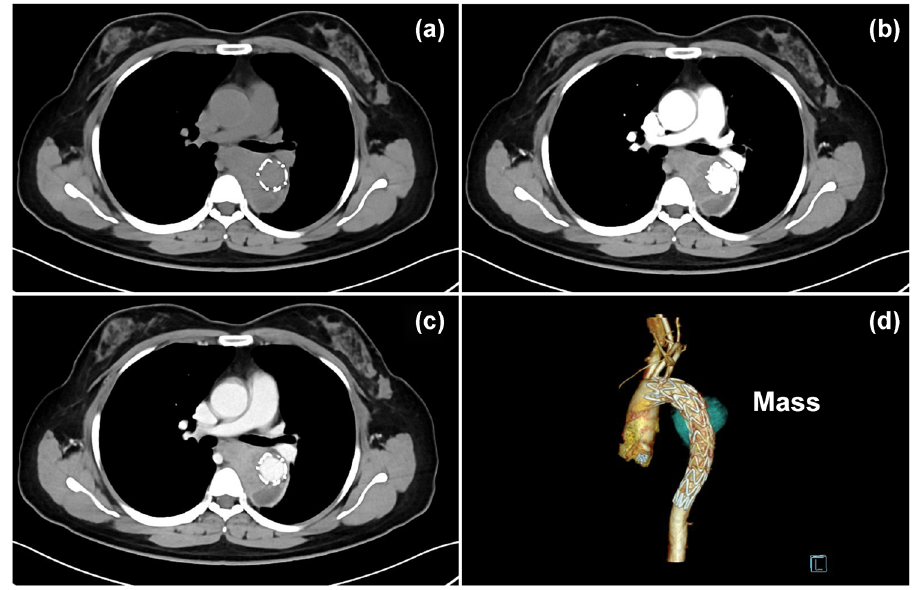
Figure 3: Axial nonenhanced CT image ( a ) and CTA ( b – d ) showing enlargement of the false lumen three months after stent implantation, with nonhomogeneous enhancement and mediastinal extensions of the false lumen, which was interpreted by radiologists in our hospital and other medical centers during follow - up as an endoleak and periaortic hematoma.